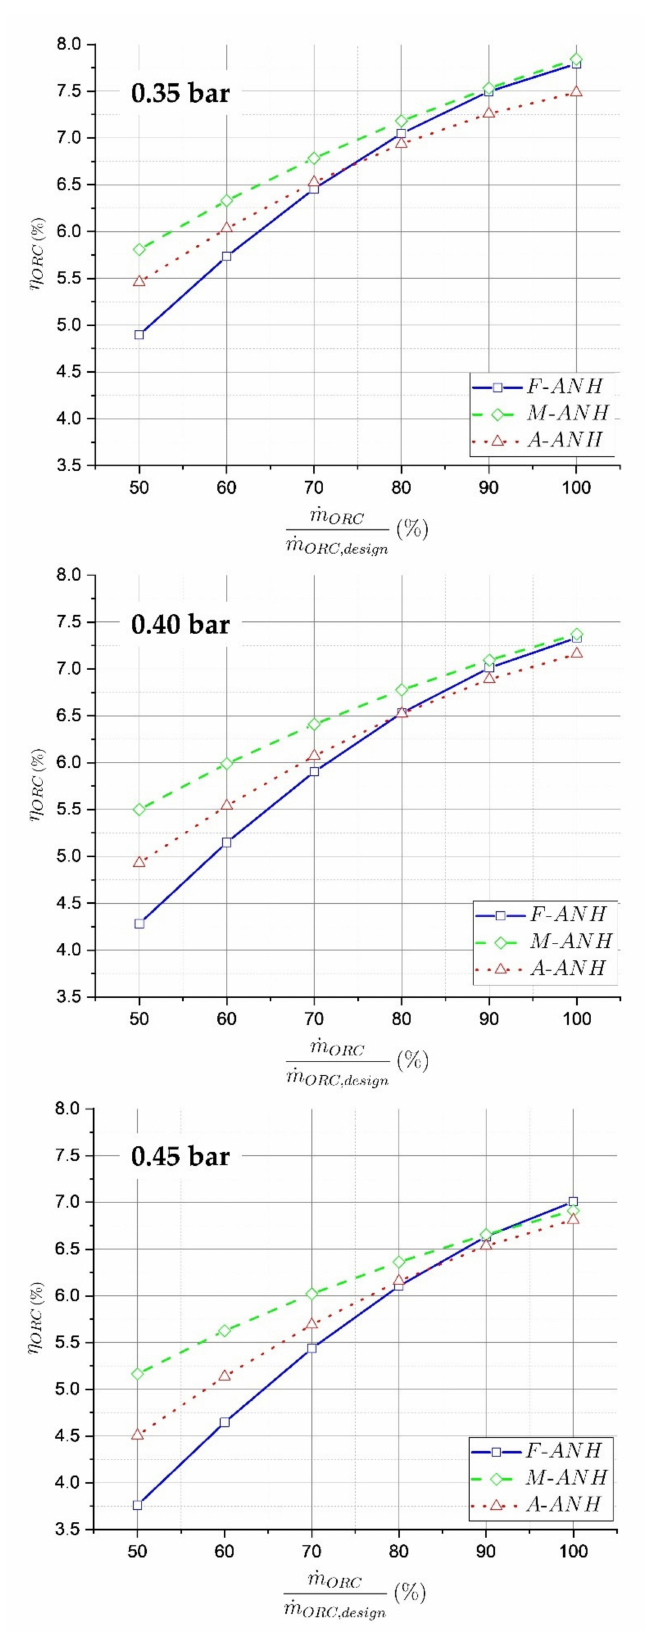
Figure 11. ORC efficiency η ORC in dependency on the working fluid mass flow rate, calculated by the digital twin for 0.35, 0.40 and 0.45 bar turbine outlet